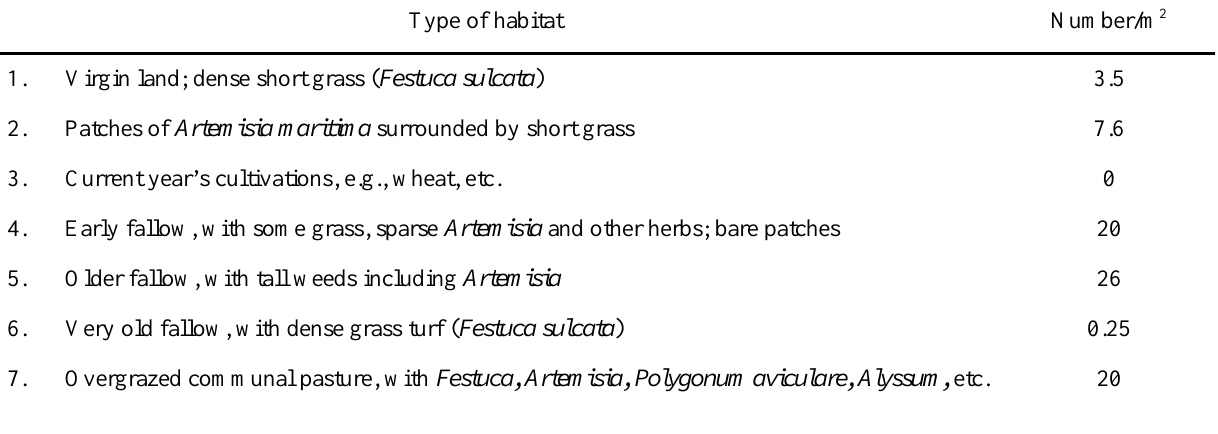
Table 1. Mean adult densities of non-swarming populations of C. italicus in different habitat types in eastern